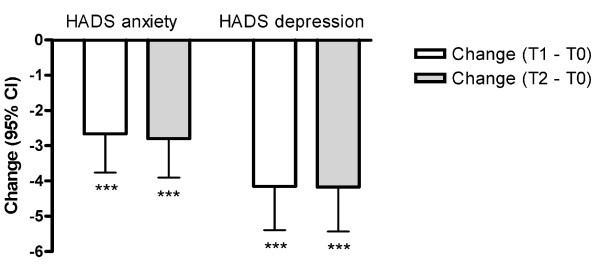
Mixed effect model analysis: mean changes and 95 CIs in the Hospital Anxiety and Depression Scale (HADS) scores after surgery. T0 is before surgery, T1 is one year after surgery, and T2 is two years after surgery. *** P < 0.001.